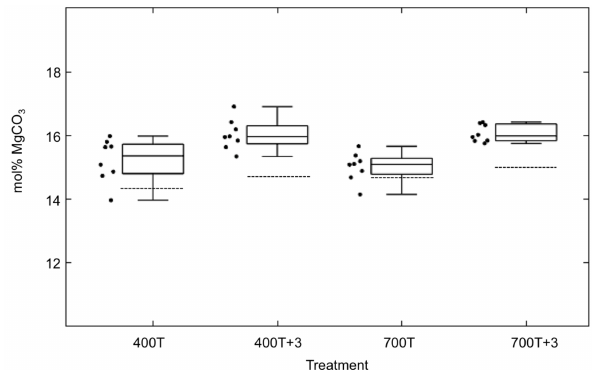
Figure 2. XRD results for new crust and pink surficial growth from the 400 and 700µatm treatments, in ambient temperature and am- bient + 3 ◦ C. Dashed lines show the mean mol% MgCO 3 for pink surficial growth. The box plots represent the new crust and the dots are individual data points. The boxes represent the 25th and 75th percentiles. The horizontal bold line is the median value, and the whiskers are minimum and maximum values. Table 3. ANOVA testing the effect of p CO 2 and temperature on dif- ference in asymmetry mol% MgCO 3 in (a) main thalli and (b) dis- solution chips of Lithophyllum cabiochae